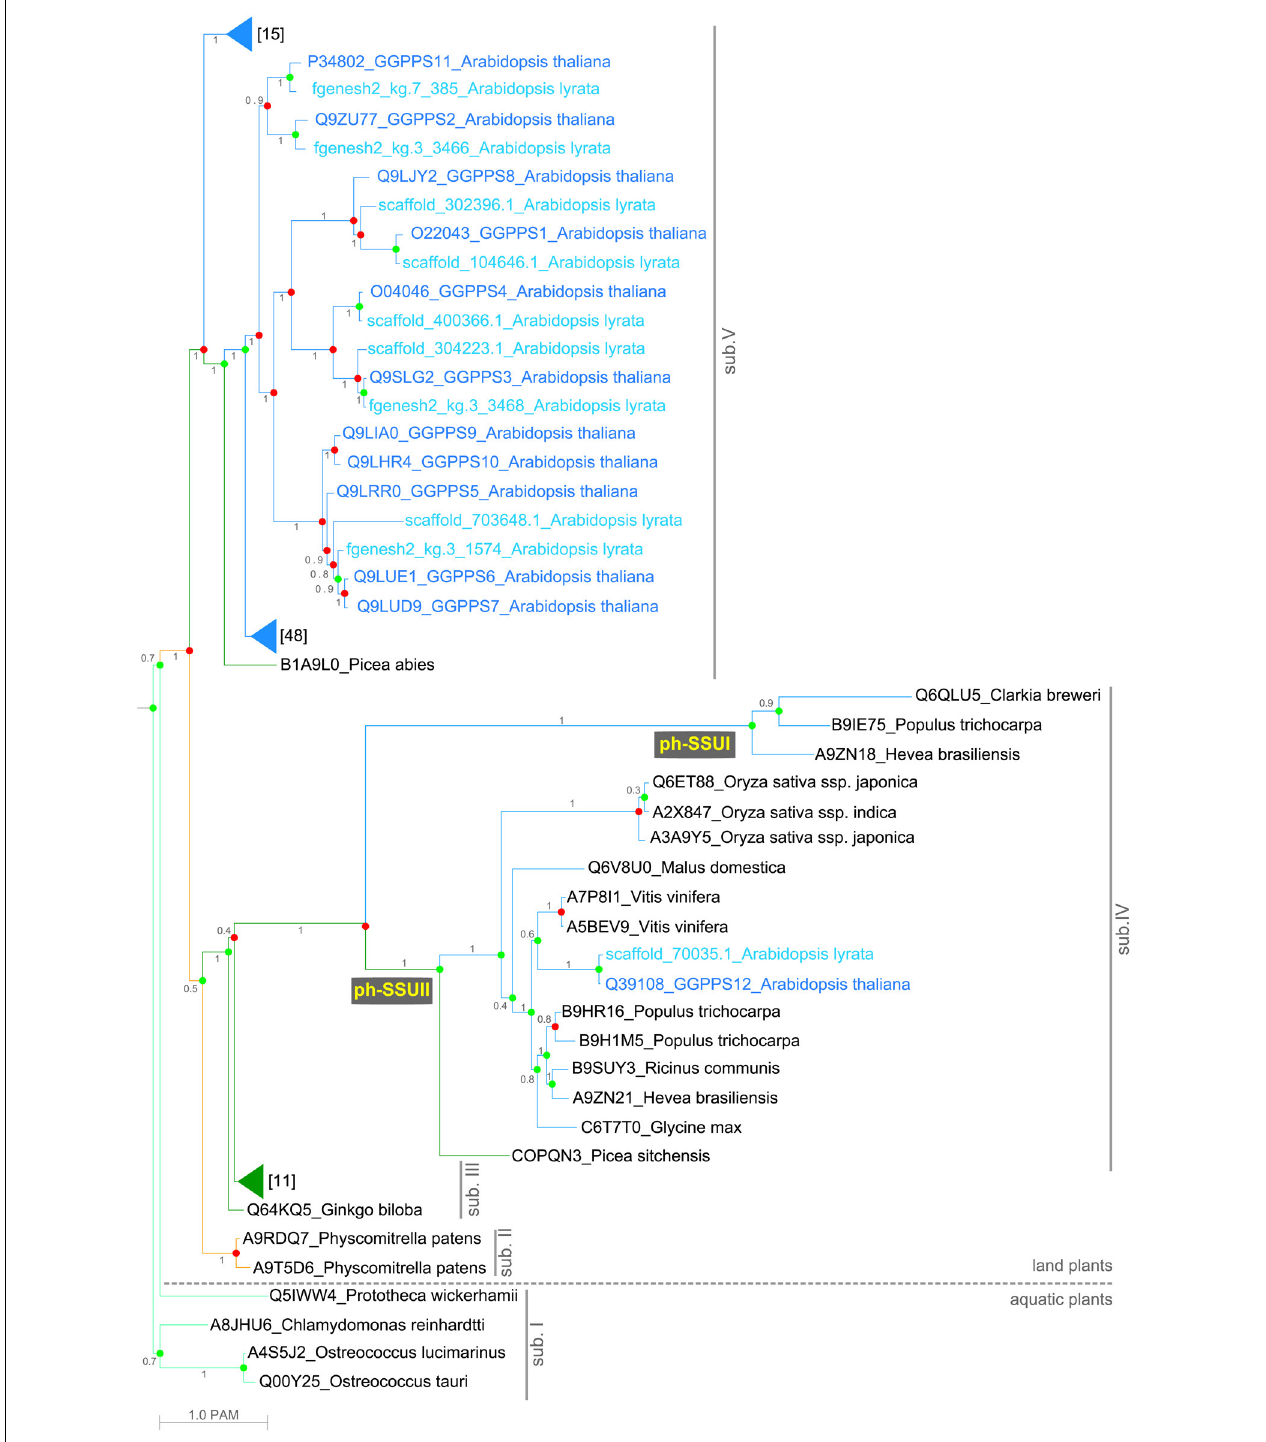
FIGURE 1 | Maximum likelihood consensus tree of the 119 GGPPS homologs from plants. Posterior probabilities are shown next to the branches. Branch lengths correspond to evolution distances (see Materials and Methods). Duplication (red dots) and speciation (green dots) events are shown at nodes. The tree is divided into five classes (sub. I–V). Branch colors